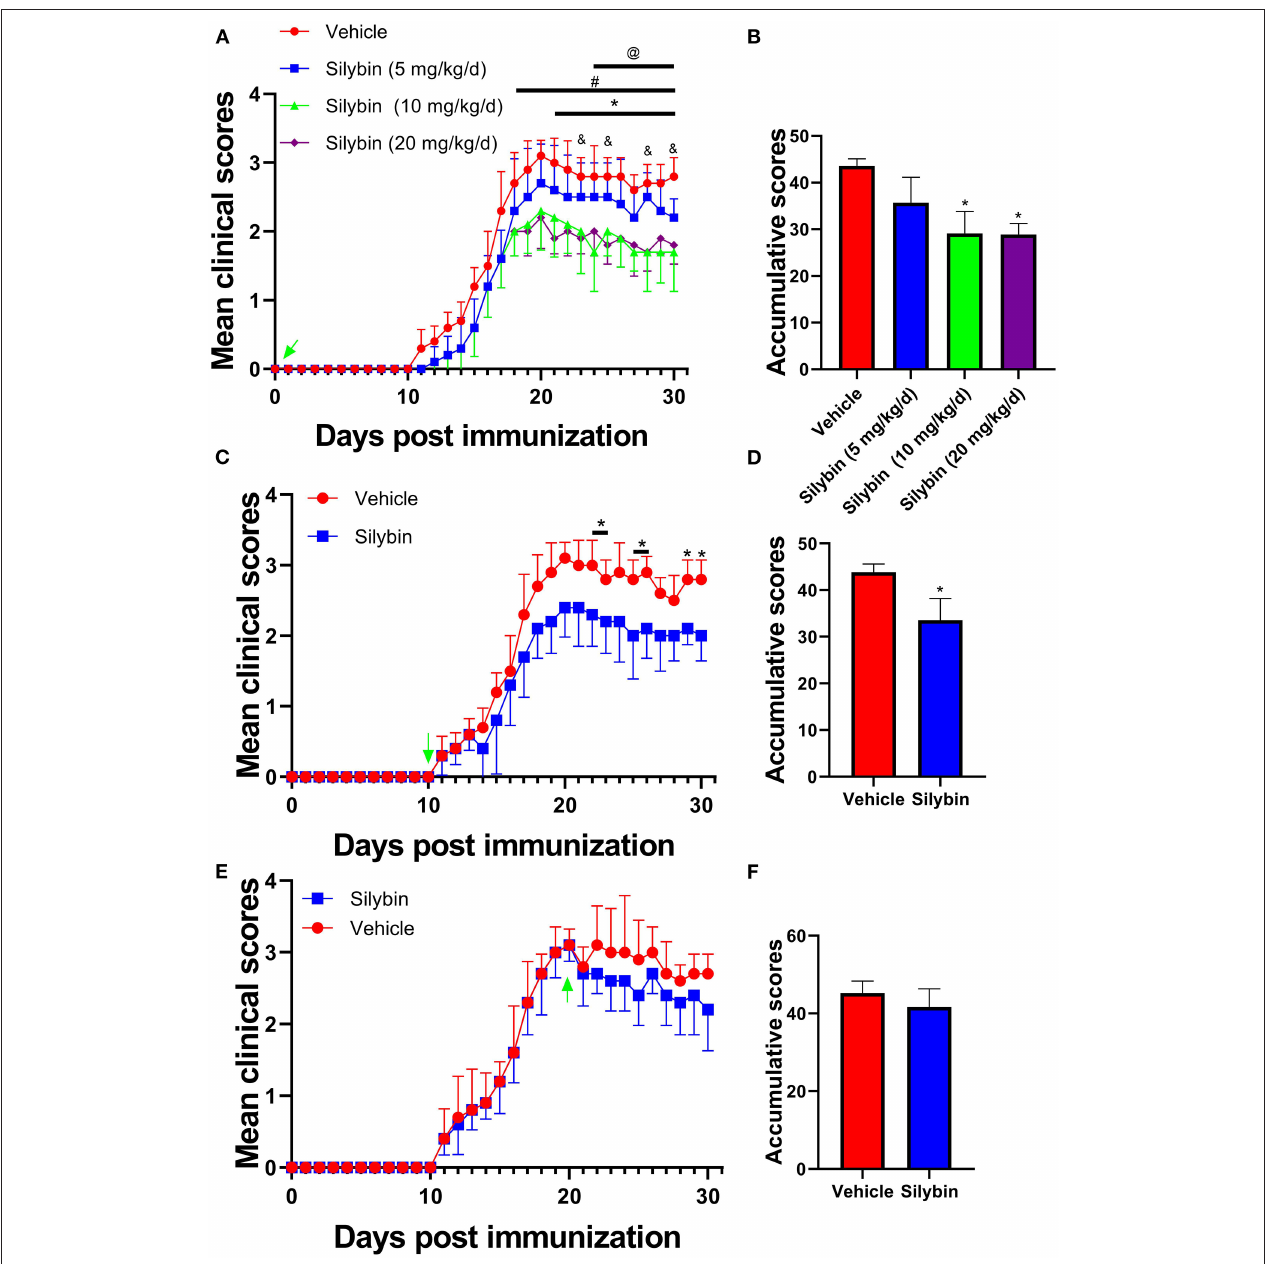
FIGURE 1 | Silybin alleviated the induction of experimental autoimmune encephalomyelitis (EAE). (A) Clinical scores were recorded daily for i.p. injection of silybin (5, 10, 20 and mg/kg/day) to EAE mice from the time of disease induction (0 day p.i.). *, comparison between 10 mg/kg/day and vehicle; #, comparison between 20 mg/kg/day and vehicle; @, comparison between 10 and 5 mg/kg/day; &, comparison between 20 and 5 mg/kg/day. (C) Clinical scores of mice treated by daily i.p. injection of silybin (10 mg/kg/day) or vehicle alone, beginning at the time of disease onset (10 day p.i.). (E) Clinical scores of mice treated by daily i.p. injection of silybin (10 mg/kg/day) or vehicle alone, starting at the time of peak stage of the disease (20 day p.i.) and scored daily following a 0–5 scale. (B,D,F) Accumulative score of EAE (sum of daily clinical scores from disease onset). Data are shown as mean values ± SD ( n = 5 each group). Two-way ANOVA or nonparametric Mann–Whitney test was used. * p < 0.05, one representative of three independent experiments is